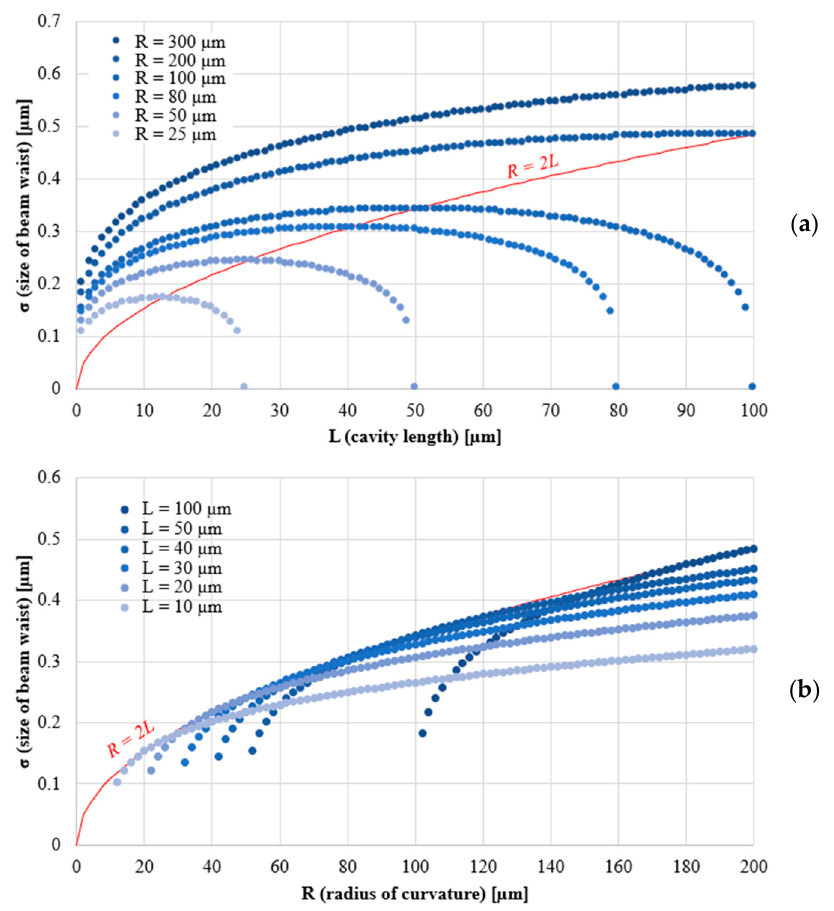
Figure 4. Simulated results show how the beam waist in a curved mirror cavity depends on ( a ) its cavity length and ( b ) the curved mirror’s radius of curvature.